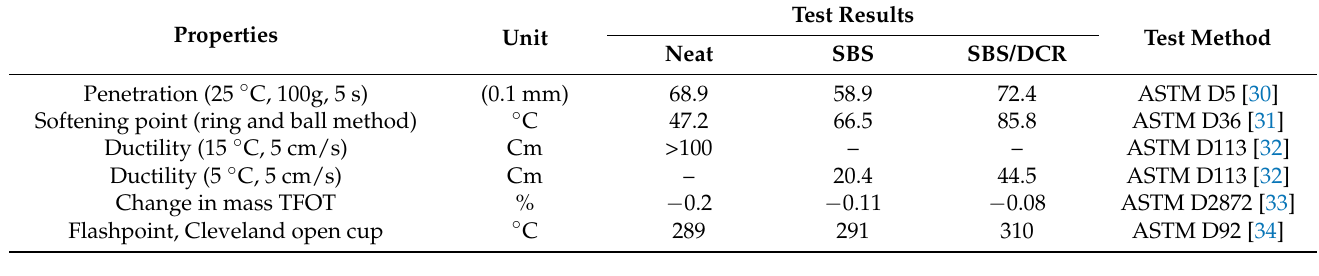
Table 1. Basic properties of bitumen.